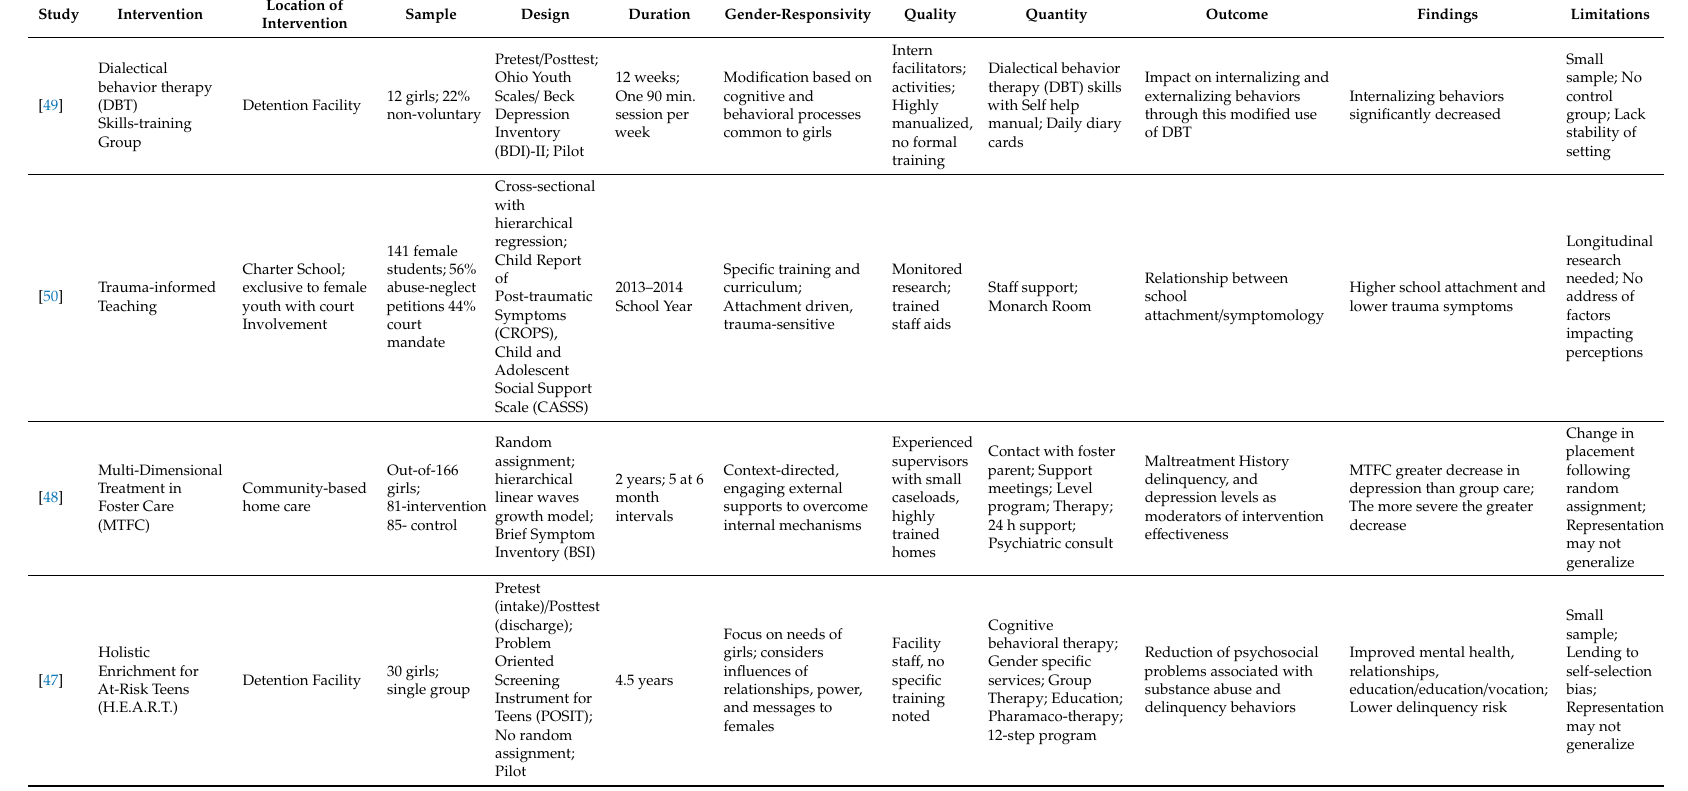
Table 1. Review of Gender-Responsive, Trauma-Informed Interventions for Justice-Involved Female